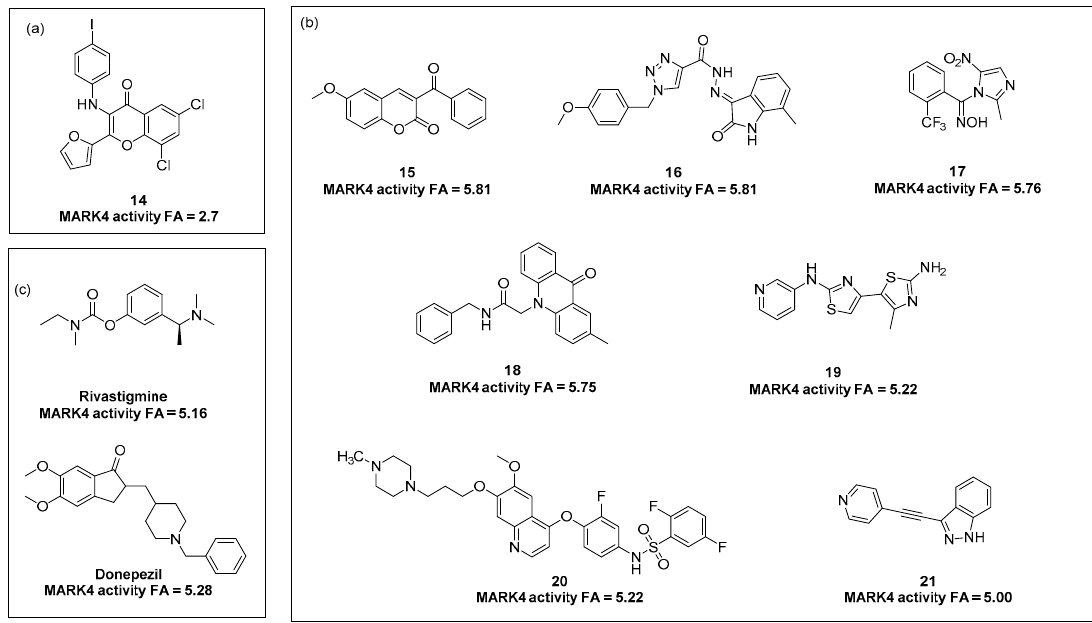
Figure 6. Representatives of weak and moderate MARK4 inhibitors with the activity descriptors; ( a ) the weak 3-N-aryl substituted-2-heteroarylchromoneinhibitor 14 [54] in comparison to the moderate 3-benzoylcoumarinMARK4 inhibitor; ( b ) the moderate inhibitors from various heterocyclic families 15 [55], 16 [56], 17 [57], 18 [58], 19 [59], 20 [60], 21 [61]; ( c ) MARK4 inhibitory properties of rivastigmine and donepezil [50]. To compare the activity expressed in various ways (IC50, K d or %inhibition at a given concentration), the formal inhibition activity descriptor (FA) was used, i.e.,: FA = p IC 50 (IC 50 ); FA = p K d ( K d ), FA = p (test concentration/0.02 × %inhibition).